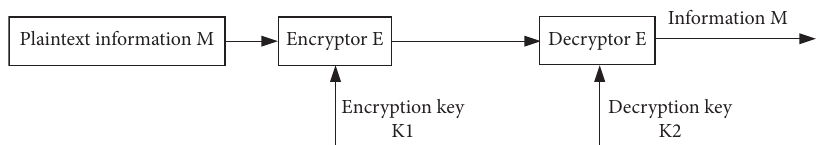
Figure 2: Cryptography encryption and decryption process.